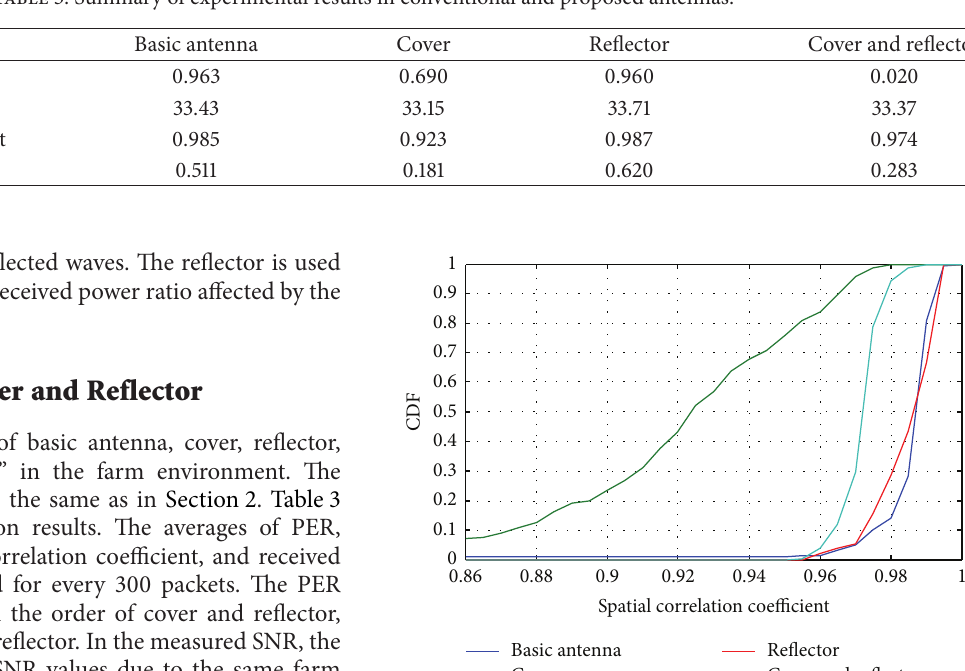
Table 3: Summary of experimental results in conventional and proposed antennas.